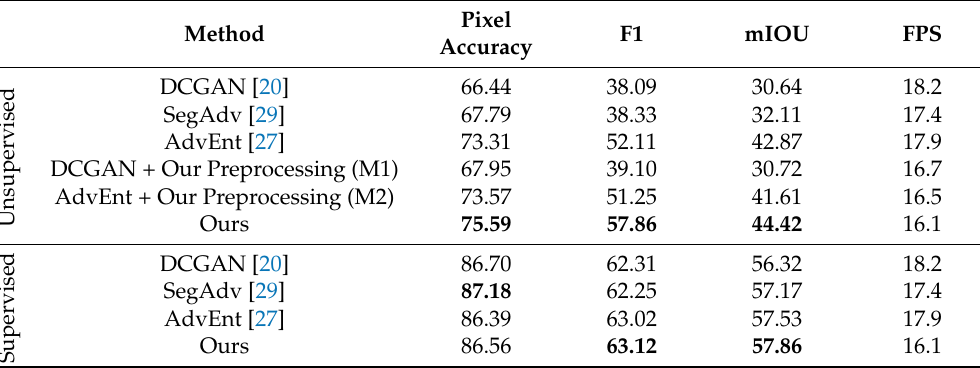
Table 3. Results on MICC-SRI dataset.